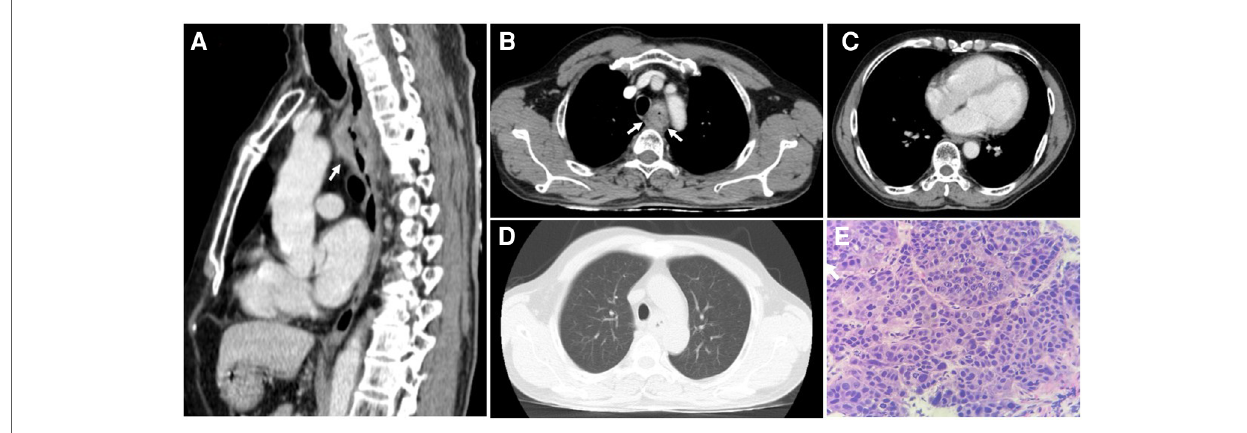
FIGURE 4 The thoracic computed tomography and histopathology before treatment strategy for esophageal squamous cell carcinoma. ( A & B) The sagittal and axial planes demonstrate that the upper esophageal tumor does not invade the surrounding structures (white arrows). ( C) The mediastinal window demonstrates normal thickness and density of ventricular and atrial walls. ( D) No parenchymal lesions are seen on the lung window. ( E) Hematoxylin and eosin-stained esophageal tissue at 400×magni fi cation showed tumor cells that possess enlarged, hyperchromasia, coarse nucleus; visible nucleoli and large cytoplasm. The tumor cells demonstrate disarray and loss of polarity in the desmoplastic